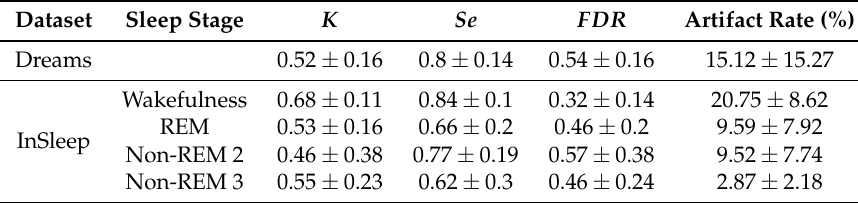
Table 5. Performance of RPs artifact detection with a 4-s epoch length.